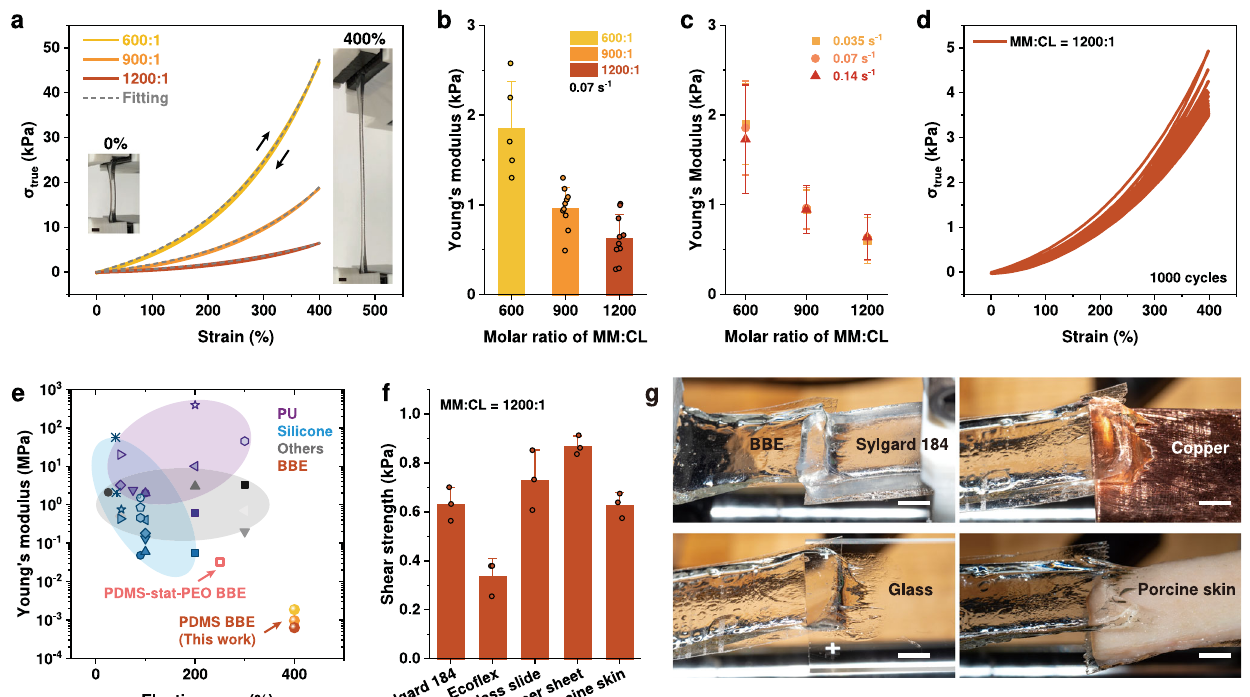
Fig. 2 | Characterizations ofpure PDMS BBEs.a Cycling tests of PDMS BBEs with different crosslinking ratios (molar ratio of MM:CL=600:1, 900:1, and 1200:1) at the strain of 400%. The dash line represents the fi tting curve obtained from the stress-strain model for unentangled polymer networks. The inset shows photo- graphs of BBE under stretching. b The Young ’ s modulus of PDMS BBEs with dif- ferent crosslinking ratios. c The comparison of Young ’ s modulus of PDMS BBEs obtained from the cyclic tests under different strain rates (0.035s − 1 , 0.070s − 1 , and 0.14s − 1 ). d Long term cycling tests (1000 cycles atthe strain of 400%)of the PDMS